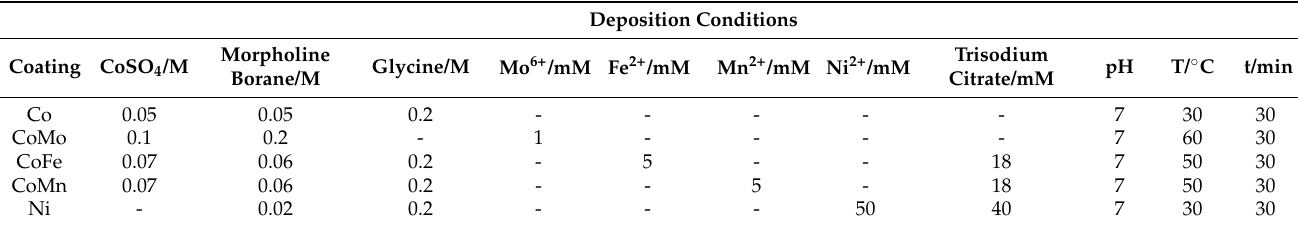
Table 1. Deposition conditions during the preparation of the herein studied